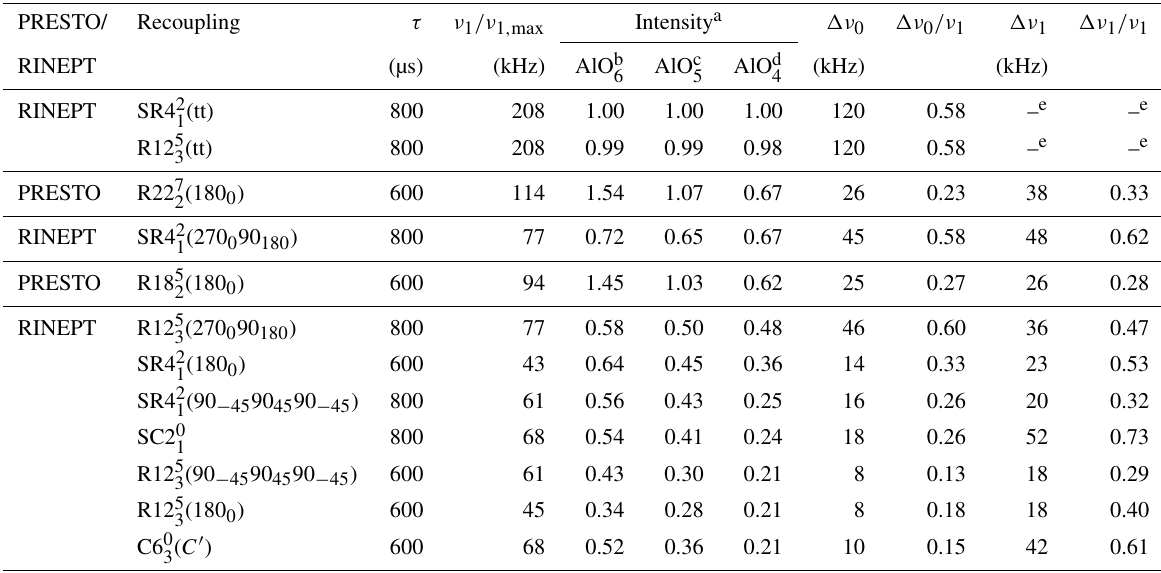
Table 2. Comparison of the performances of 1 H → 27 Al RINEPT-CWc and PRESTO transfers with AlPO 4 -14 at ν R = 20kHz.